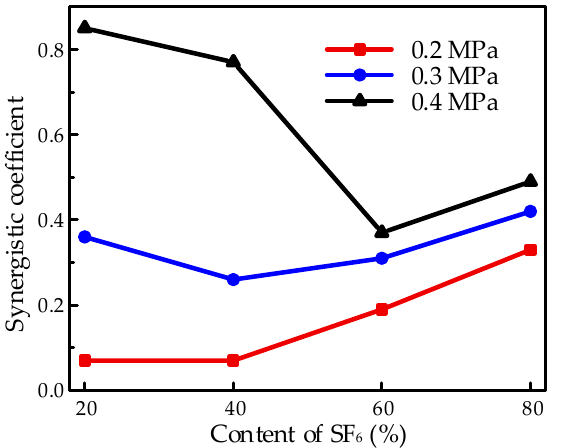
Figure 11. Relation between the synergistic coefficient and the content of SF 6 with a needle-plate electrode system.